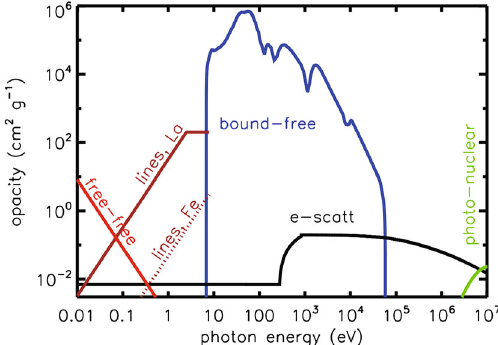
Fig. 4 Schematic illustration of the opacity of the NS merger ejecta as a function of photon energy near peak light. The free–free opacity ( red line ) is calculated assuming singly-ionized ejecta of temperature T = 2 × 10 4 K and density ρ = 10 − 14 g cm − 3 , corresponding to the mean properties of 10 − 2 M (cid:4) of ejecta expanding at v = 0 . 1c at t = 3 days. Line opacities of Fe-like elements and lanthanide-rich elements are approximated from Figs. 3 and 7 of Kasen et al. (2013). Bound-free opacities are estimated as that of neutral Fe (Verner et al. 1996), which we expect to crudely approximate the those of heavier r -process elements. Electron scattering opacity accounts for the Klein–Nishina suppression at energies (cid:11) m e c 2 and (very schematically) for the rise in opacity that occurs above the keV energy scale due to all electrons (including those bound in atoms) contributing to the scattering opacity when the photon wavelength is smaller than the atomic scale. At the highest energies, opacity is dominated by pair creation by γ -rays interacting with the electric fields of nuclei in the ejecta (shown schematically for Xenon, A = 131, Z = 54). Not included are possible contributions from r -process dust; or γ – γ pair creation opacity at energies (cid:11) m e c 2 , which is important for high compactness (cid:14) (cid:11) 1 (Eq.